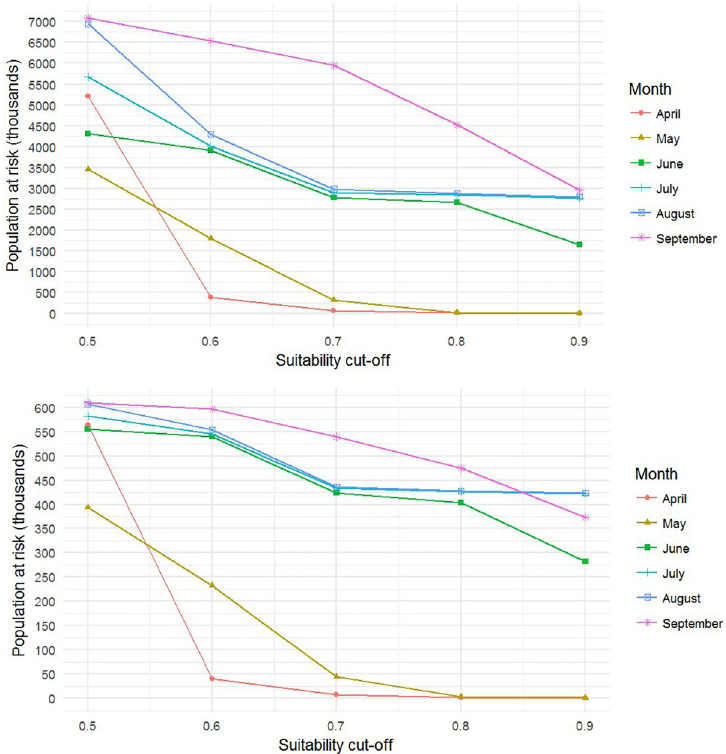
Fig 7. Population at risk of Phlebotomus papatasi exposure between April and September using different suitability cut-off points from moderate (0.5) to very high (0.9) suitability calculated using (top) the Global Population of the World (GPW) grid and (bottom) the European Commission’s Global Human Settlement (GHS) population grid.